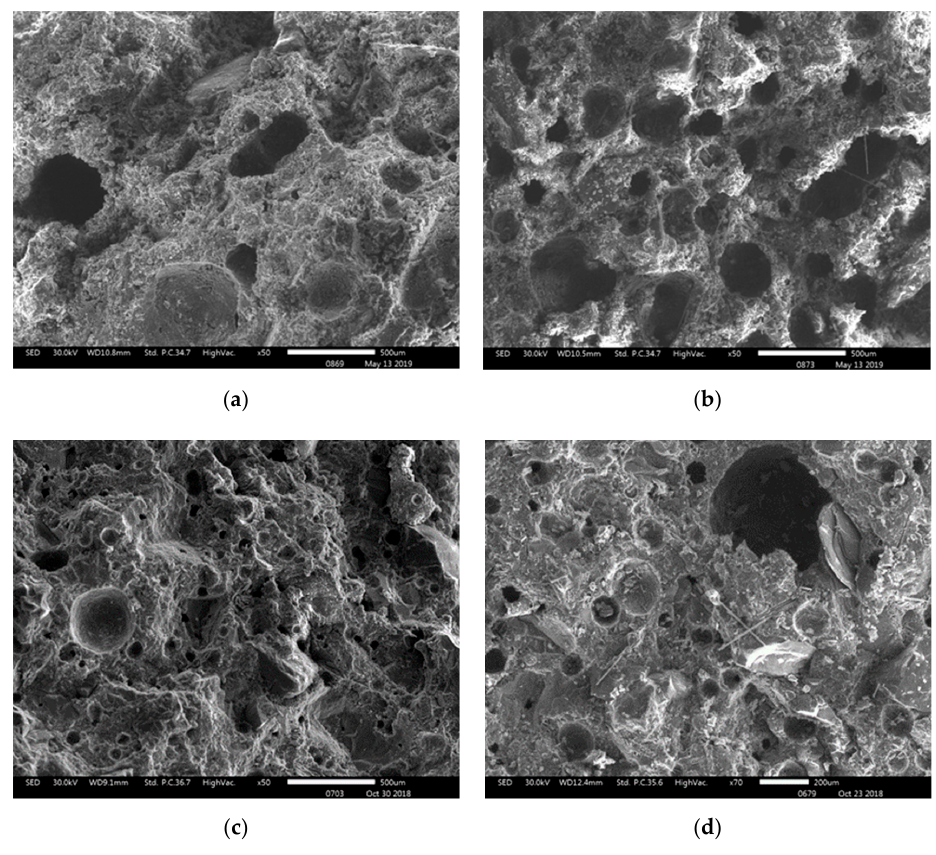
Figure 2. SEM of fracture surface of NSCFRC, ( a ) PC (0% CFs, 0% NS); ( b ) S0 (0.15% CFs, 0% NS); ( c ) S2 (0.15% CFs, 1% NS); ( d ) C2 (0.25% CFs, 1% NS). Materials 2019 , 12 , x FOR PEER REVIEW